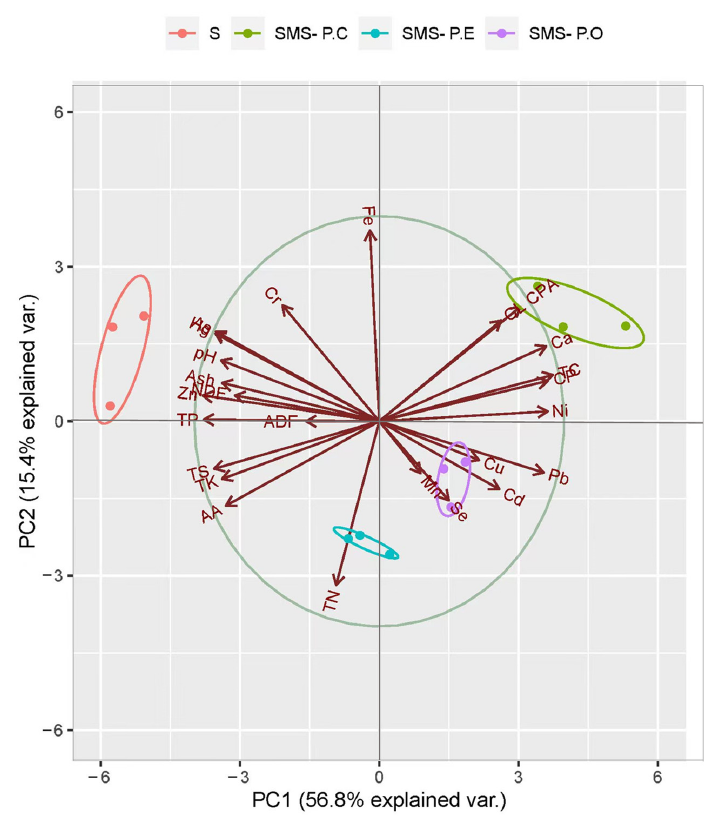
Figure 4. Biplot representing the fi rst (PC1) and second (PC2) axes of principal component analysis, showing ordination of treatments, according to nutrient and elemental variables measured in substrate (S) and three varieties of SMS (SMS-P.E, SMS-P.O, and SMS-P.C). Variables are percentage coverage by neutral detergent fiber (NDF), acid detergent fiber (ADF), ash (ASH), crude polysaccharide (CPA), crude protein (CP), crude lipid (CL), total sugar (TS), amino acids (AA), total carbon (TC), total nitrogen (TN), total phosphorus (TP), total potassium (TK), pH, Ca, Cu, Fe, Zn, Mn, Se, Cd, Cr, Hg, Pb, As, and Ni.